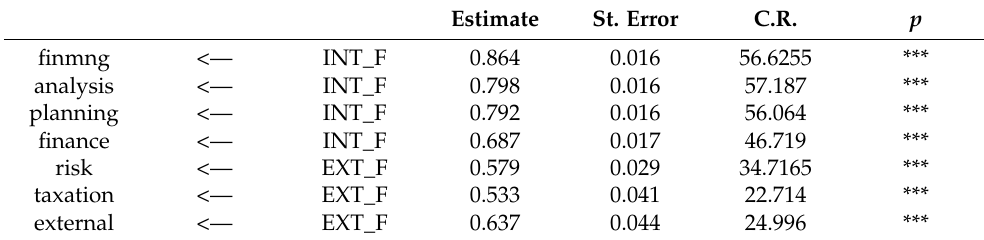
Table 2. Standardized estimates, errors, and reliability of the total